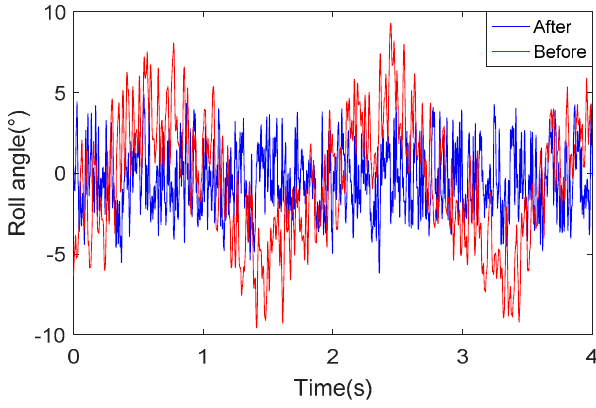
Figure 19. Rolling attitude angle difference.